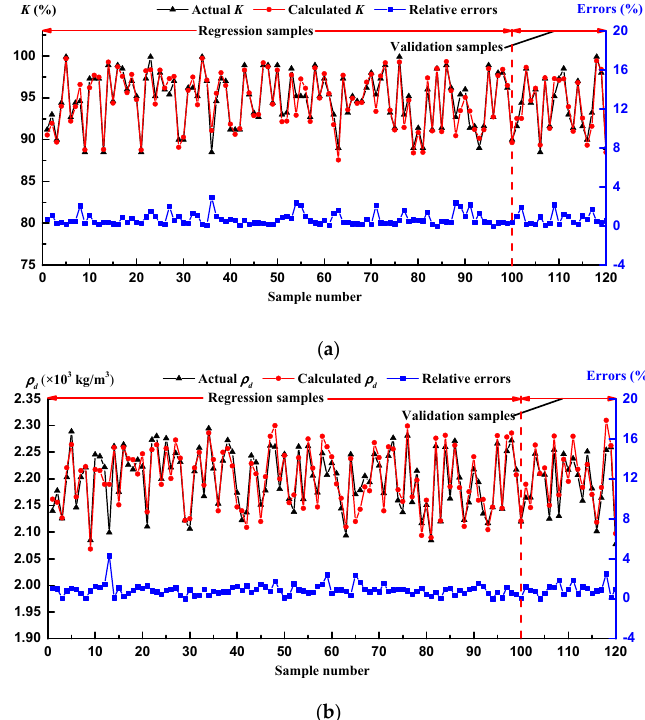
Figure 5. Cross validation of physical indices: ( a ) K ; ( b ) 𝜌 (cid:3031) .